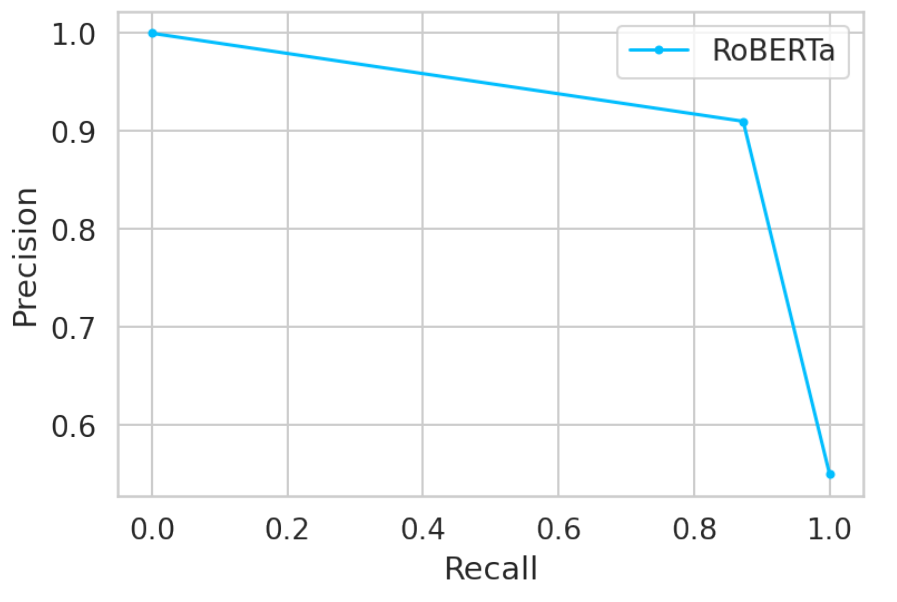
Figure 18. Precision and Recall Curve for RoBERTa. Table 14. Parameter Setting.